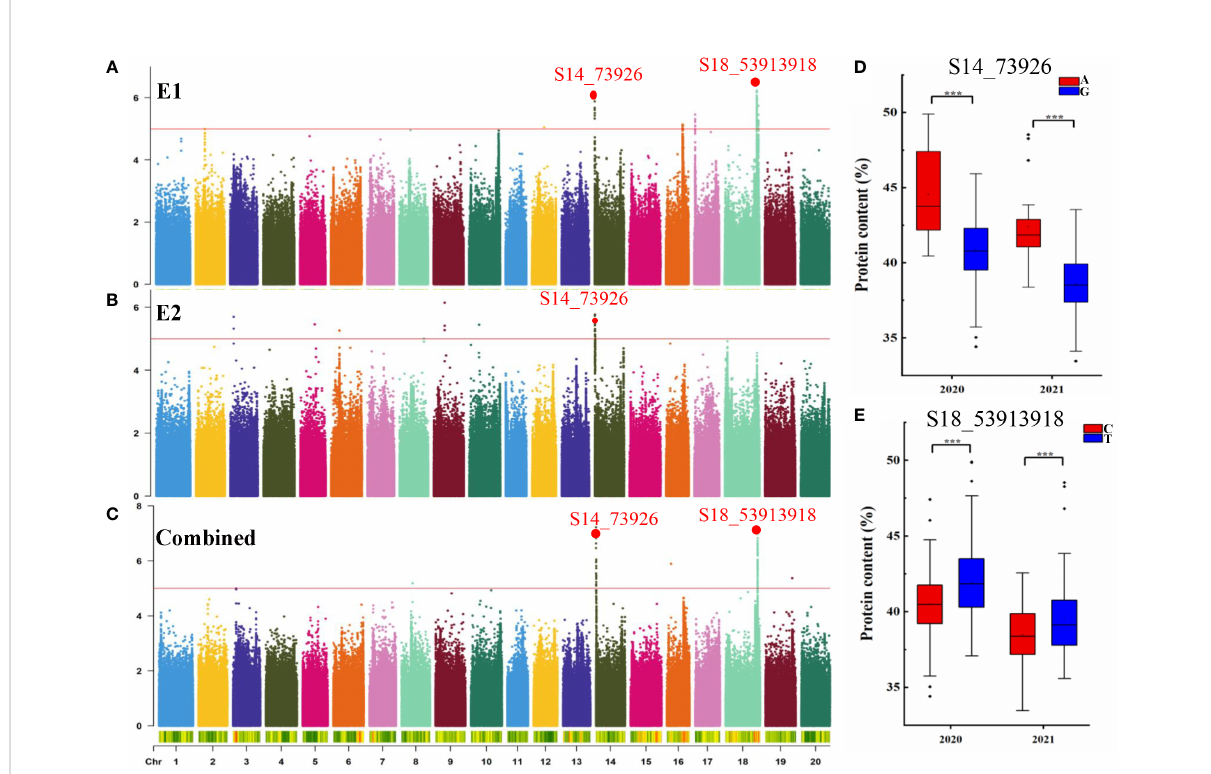
FIGURE 2 GWAS for seed protein content (PC). Manhattan plot for seed PC in E1 (A) , E2 (B) , and combined (C) . The red line indicates the signi fi cance threshold at -log 10 ( p ) = 5. (D) Boxplots for seed PC based on the S14_73926-A/G alleles in 2020 and 2021. (E) Boxplots for seed PC based on the S18_53913918-G/T alleles in 2020 and 2021. ***p <